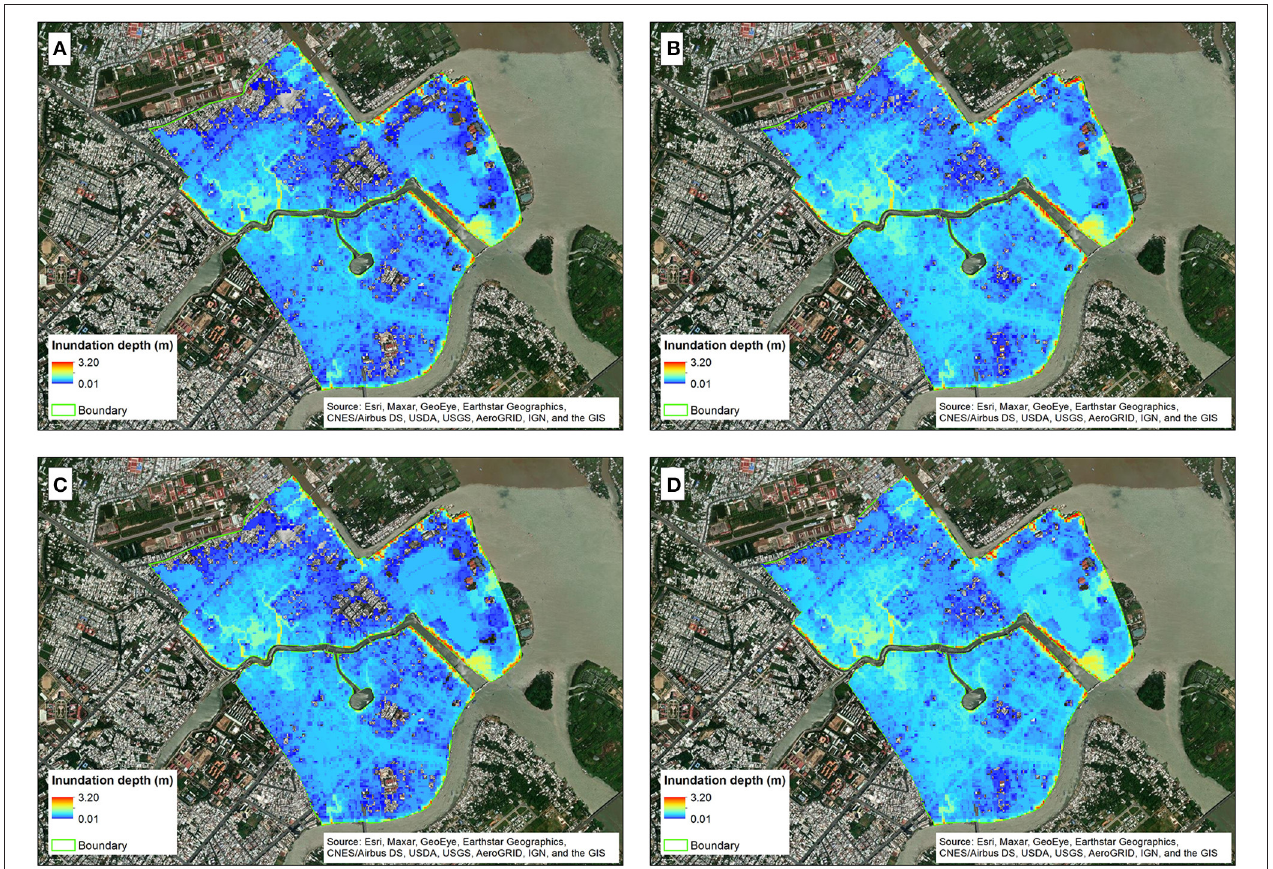
FIGURE 13 | Flood hazard maps corresponding to 5 year and 100 return period of water level for 2050 under RCP 4.5 (model scenario #2) (A,B) , and RCP 8.5 (model scenarios #4) (C,D) ,